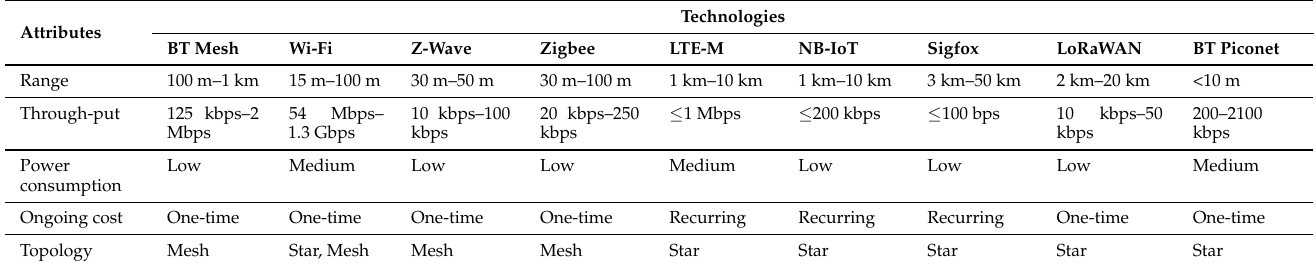
Table 3. The comparison of BT Mesh with other